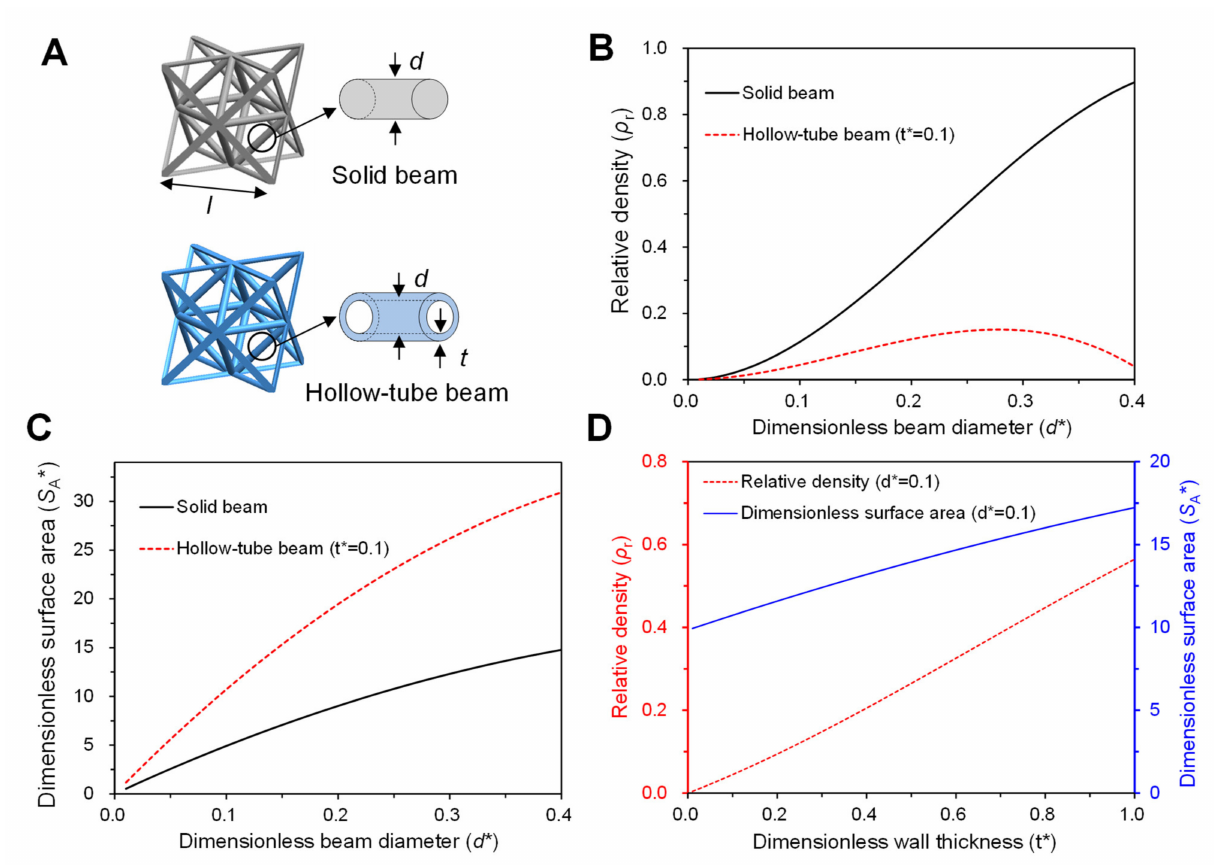
Figure 1. ( A ) Schematics of 3D microlattices with solid and hollow-tube beams. ( B – D ) Relative density ( ρ r ) and dimensionless surface area ( S A* ) of the solid and hollow-tube beam microlattices as a function of d * and t * ,